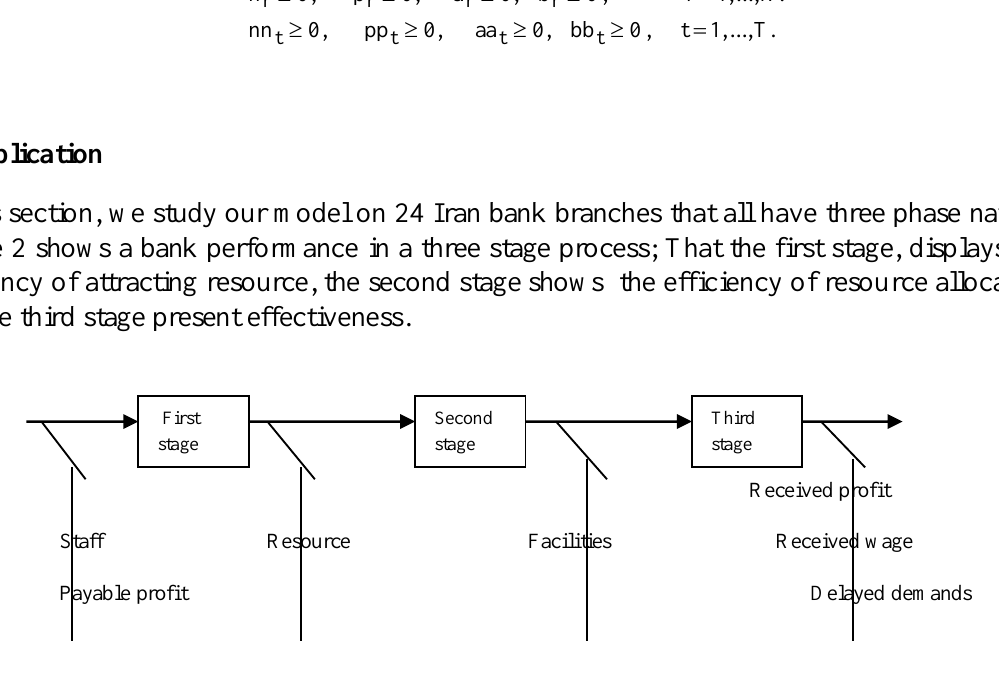
Figure 2: A Bank performance with